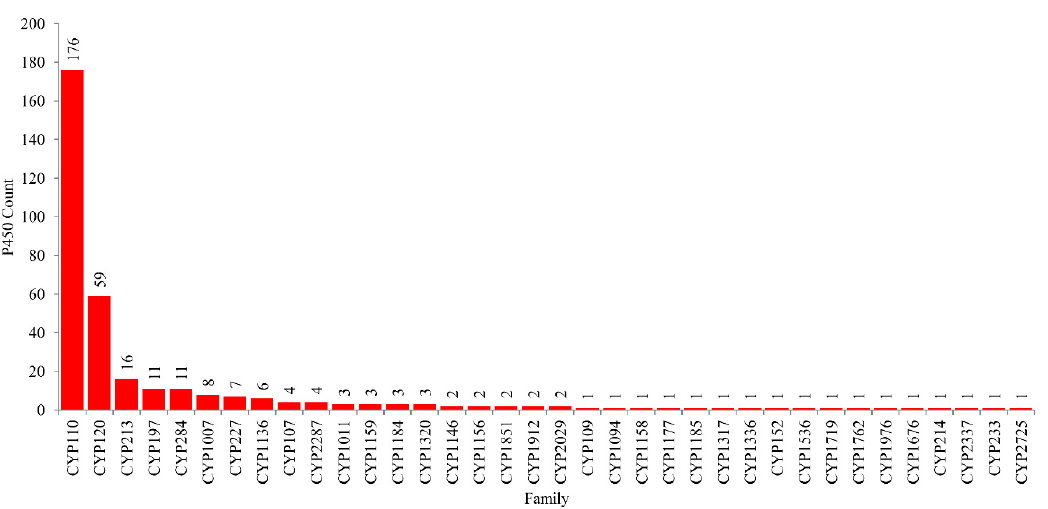
Figure 4. Family level comparative analysis of P450s in the species of Cyanobacteria . The numbers next to the family bar indicate the number of P450s. The data on the number of P450 families, along with subfamilies, are presented in Supplementary Table S3.